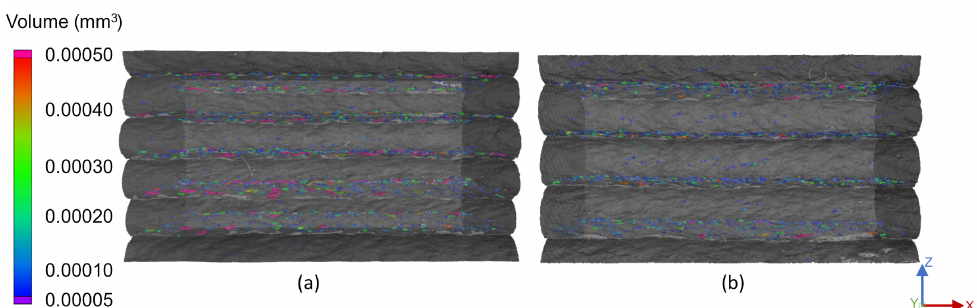
Figure 6. Side view of the porosity of two single-strand specimens at a substrate temperature of 170 °C and a layer height of ( a ) 0.8 mm and ( b ) 1.0